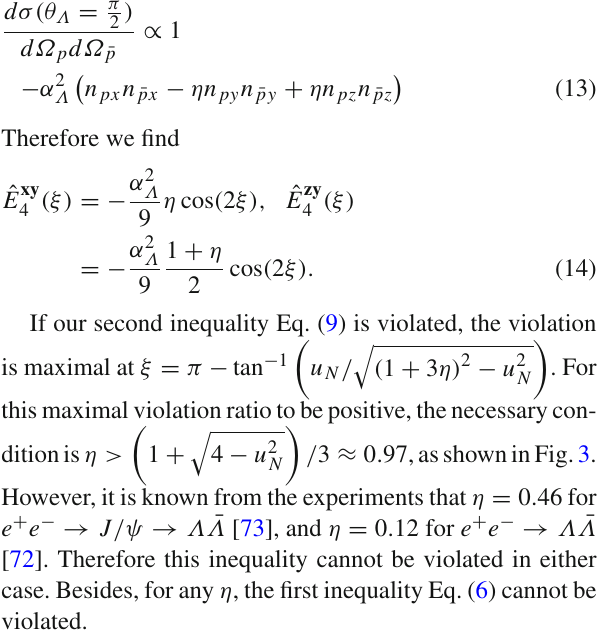
Consider the η c process. The first inequality Eq. (6) implies L η c = 2 α 2 Λ | cos (ϕ) + 1 | / 9, thus the maximum of the vio- / lation ratio is r m = u 2 N